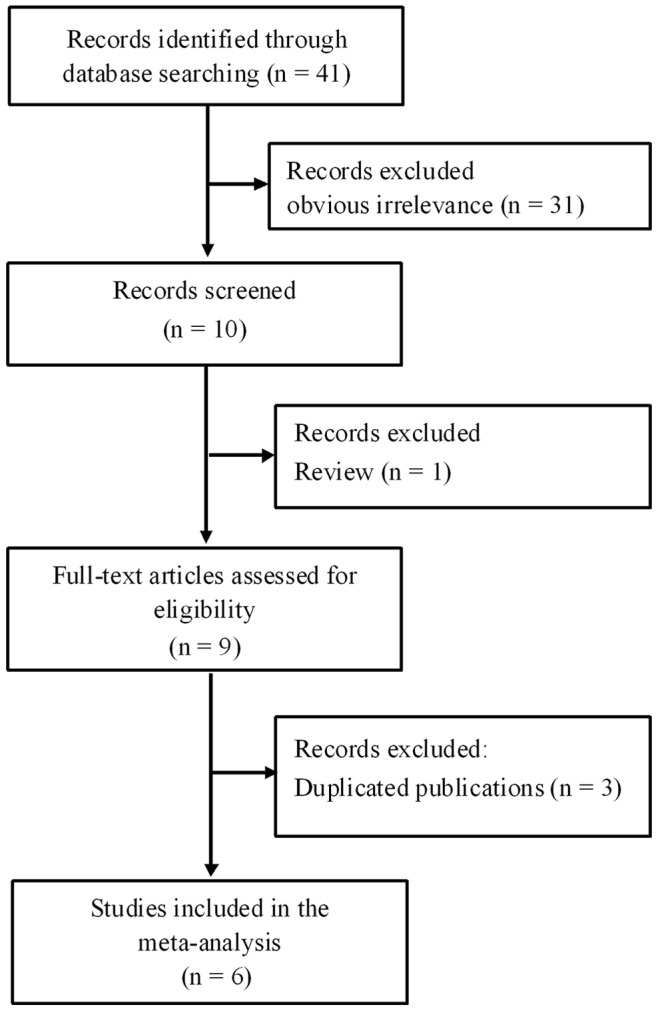
Flow diagram for study selection and specific reasons for exclusion in the meta-analysis.